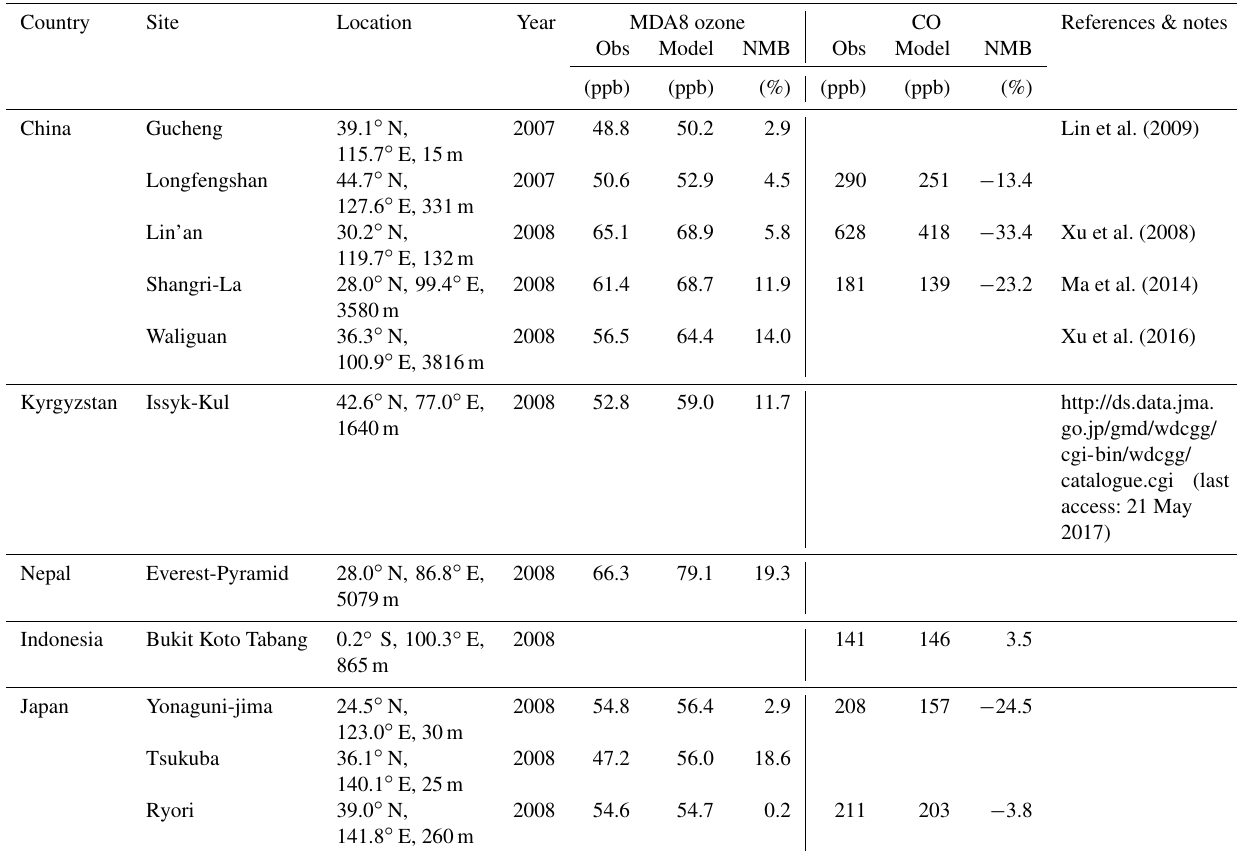
Table 3. Comparison of simulated and observed springtime MDA8 ozone and CO at five regional background sites in China and six global background stations near China with hourly